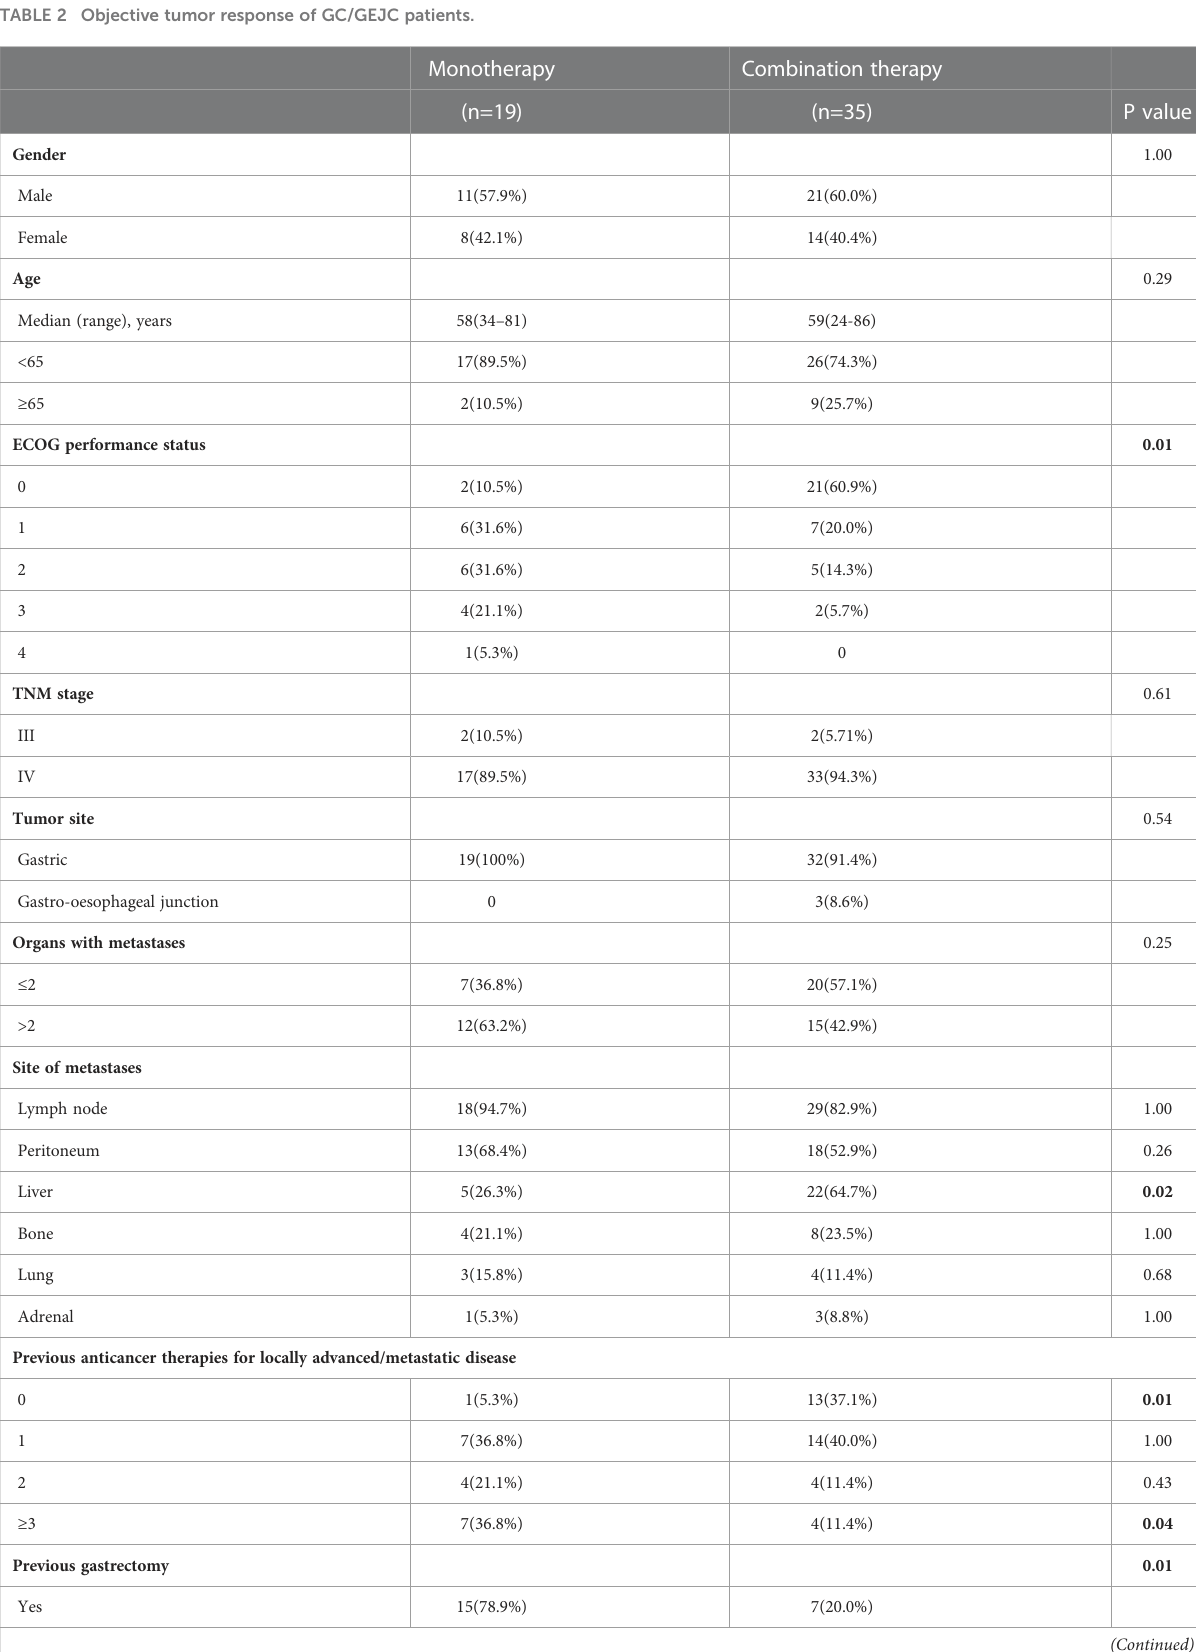
TABLE 2 Objective tumor response of GC/GEJC